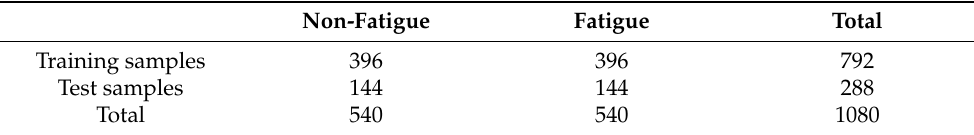
Table 5. Number of samples.